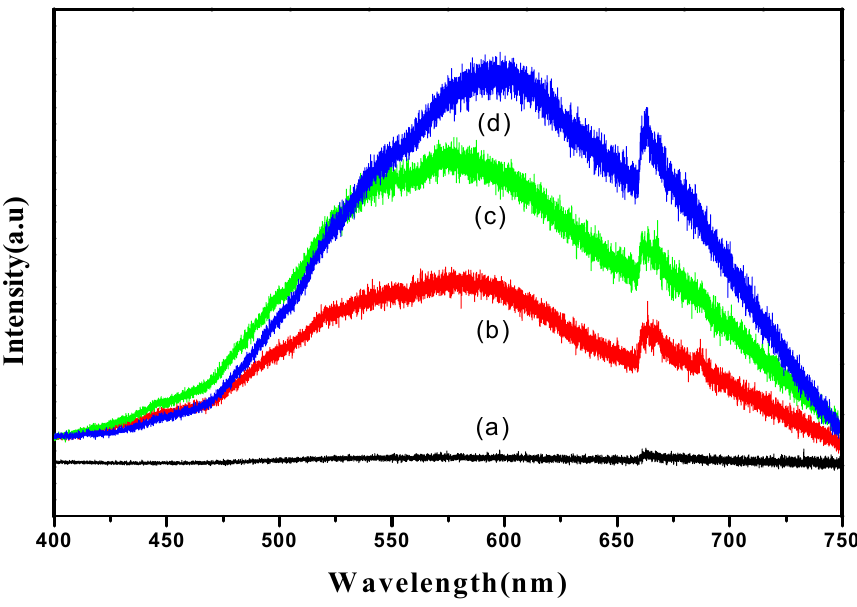
Figure 6. PL spectra of ( a ) 30 s; ( b ) 10 min; ( c ) 20 min and ( d ) 60 min samples.